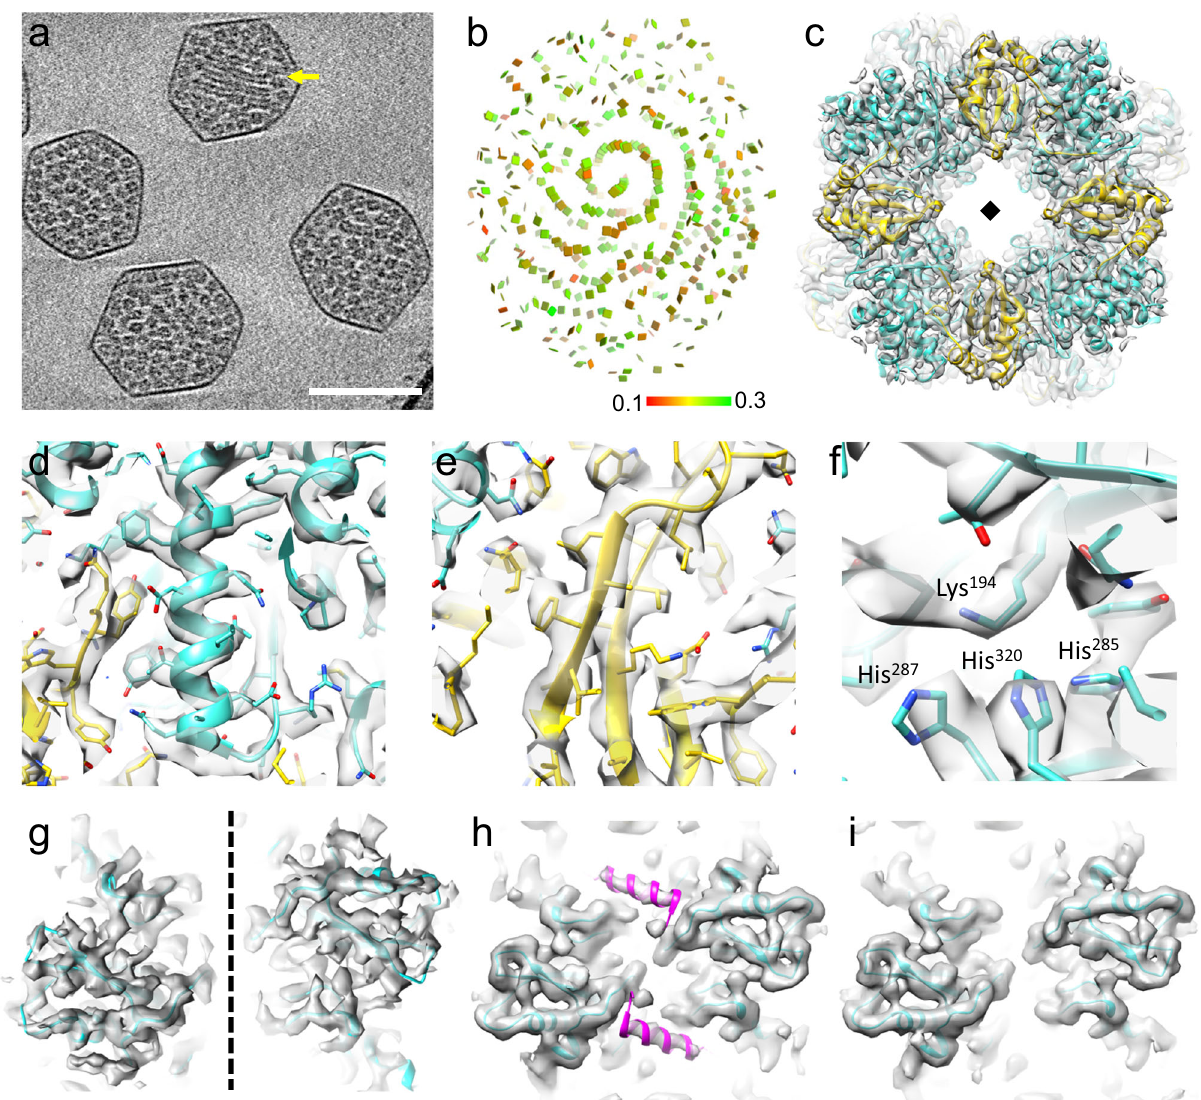
Fig. 2 | Structure and organization of Rubisco within native Halo carboxy- somes.a Atomogramslice(33.5Athickness)containingfour Halo α -carboxysomes (from n =60). Strings of Rubisco are marked by the yellow arrow. b The position and orientation of individual Rubisco mapped back to the tomogram of carboxy- some, shown in a square plate as in Fig. 1b. c Cryo-ET STA structure of Rubisco at 3.3Å resolution, overlapped with the real-space re fi ned atomic model. CbbL and CbbS are colored in cyan and yellow, respectively. d , e Details of Rubisco density